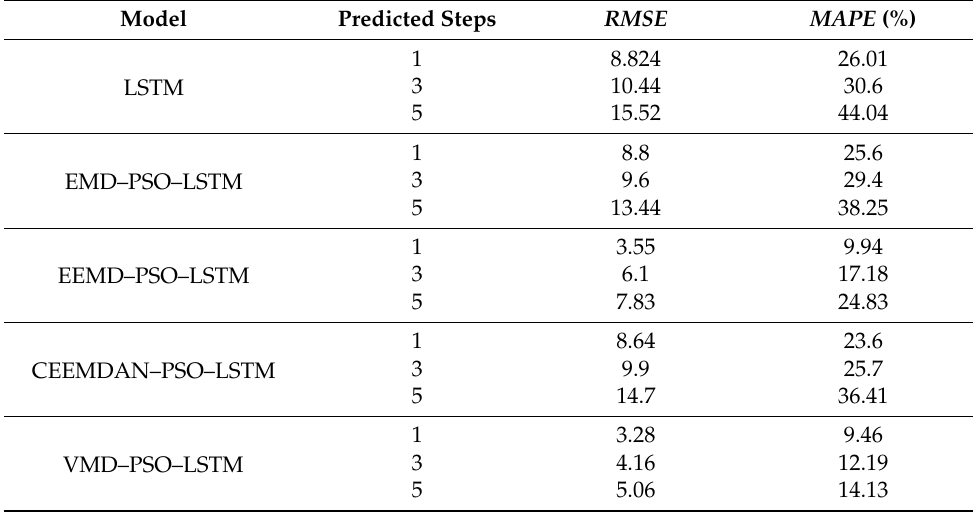
Figure 9. Error results for different decomposition prediction models (14–23 June 2019), one-step prediction error (blue line), three-step prediction error (red line) and five-step prediction error (yellow line). Table 6. Evaluation metrics for different decomposition prediction